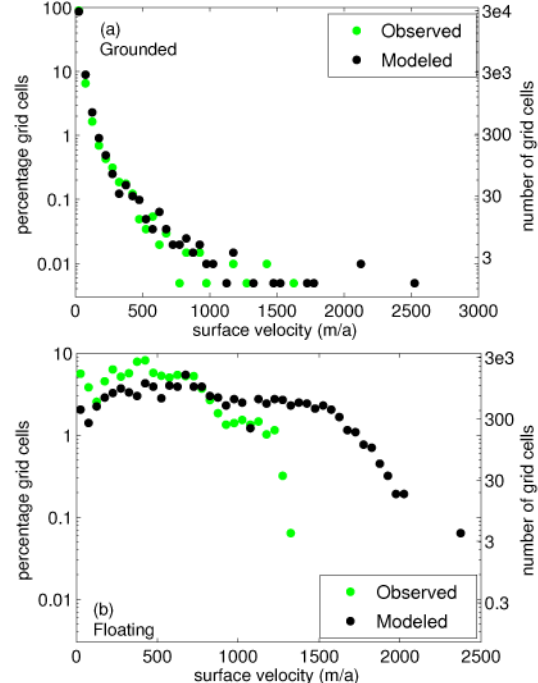
Fig. 16. Histogram of velocity distribution. Panel (a) grounded and panel (b) floating areas (please note that the strongest overes- timation occurs only for a small number of grid cells). Relative to Fig. 15, we show results from the smaller dataset (Fig. 13), contain- ing only data where there is agreement between model and obser- vation about whether the ice is grounded or